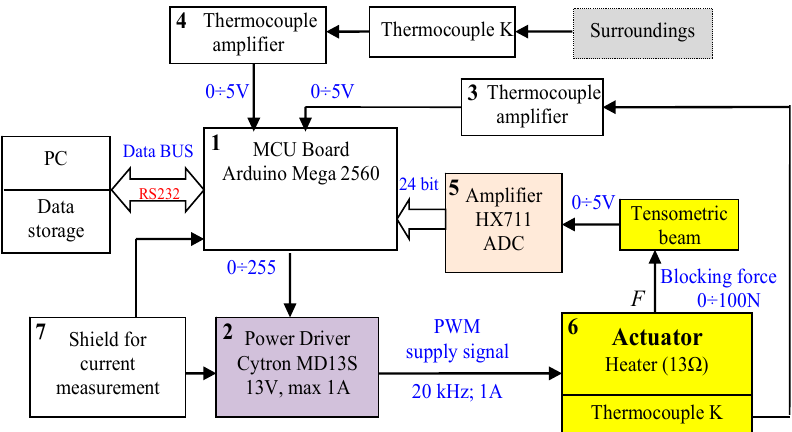
Figure 6. Block scheme of the test stand for measuring blocking